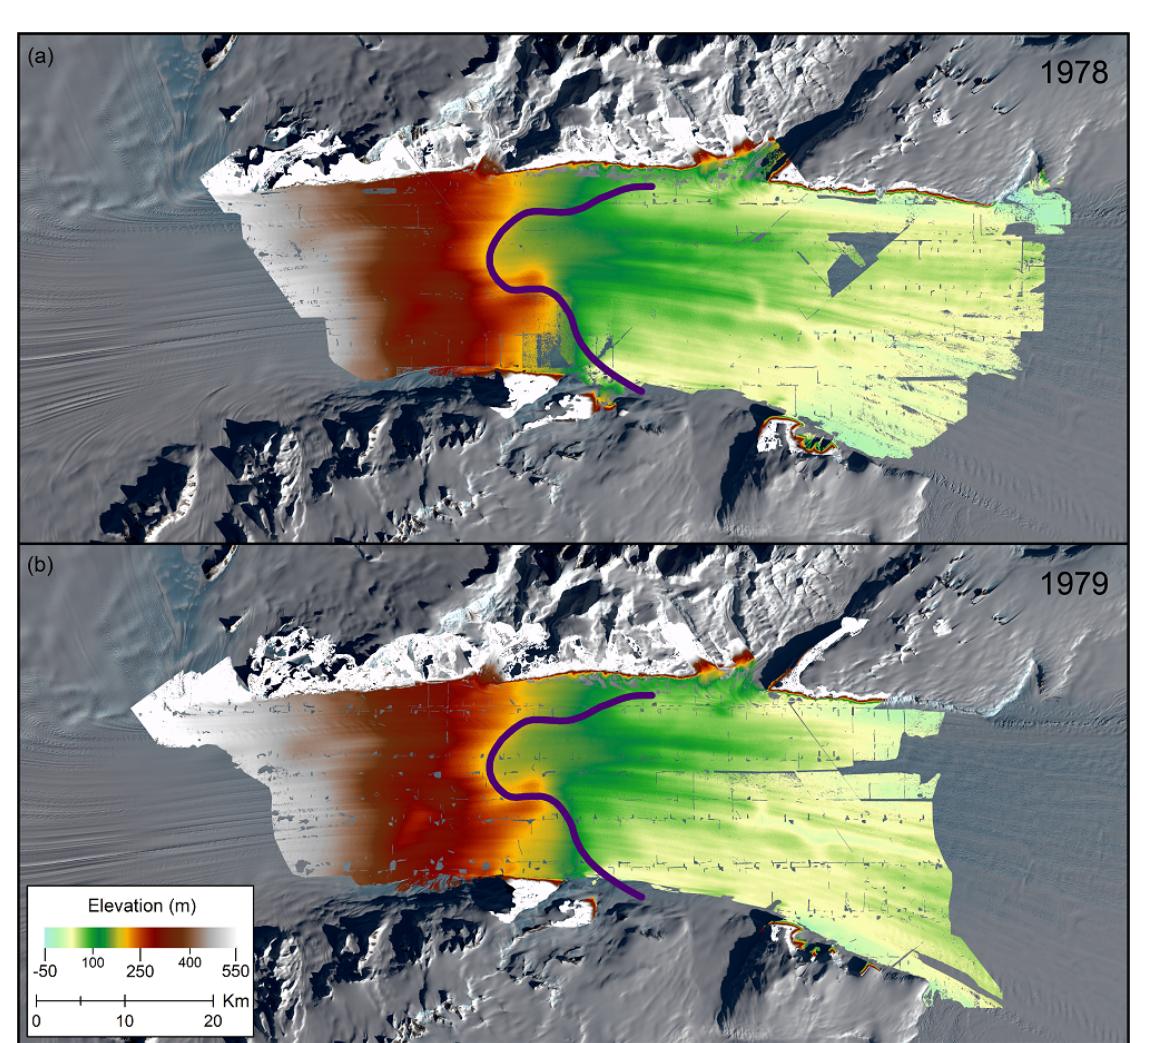
Figure 6. SfM photogrammetry DEM results for the 1978 ( a ) and 1979 ( b ) image sets with a spatial resolution of 10 m after the removal of any spurious elevation values. The upper end of the color bar is set to 550 m to highlight the glacier’s surface features. The gaps in the data are blunders removed from the point clouds